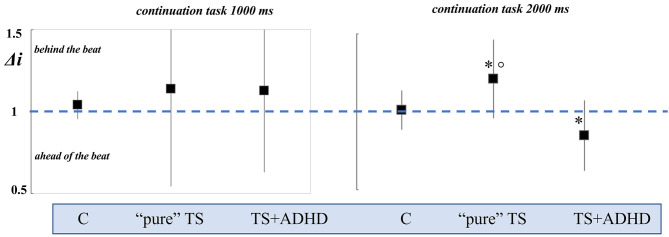
Representation of accuracy index (Δi) in Condition B (synchronization and continuation task) for t = 1,000 ms and for t = 2,000 ms. The Δi value is 1 in the iso-synchrony performance (dashed blue line); values >1 or <1 indicate the direction of continuation tapping, “behind the beat” or” ahead of the beat,” respectively. “Pure” TS and TS+ADHD patients showed a lack of accuracy in the continuation task for 2,000 ms, with opposite directions. “Pure” TS: Tourette syndrome only; TS+ADHD: Tourette syndrome plus; C: controls; *p < 0.05 Bonferroni post-hoc test with 95% CI vs. controls; °p < 0.001 Bonferroni post-hoc test with 95% CI “pure” TS vs. TS+ADHD.